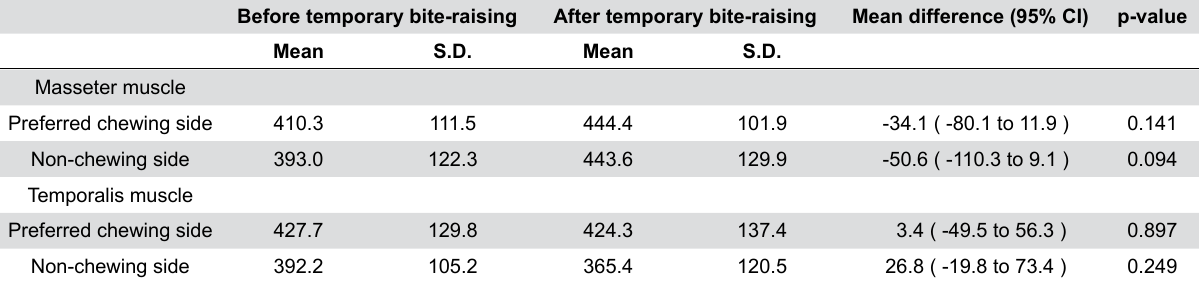
Table 4- Duration (ms) of the identified burst during mastication before and after temporary